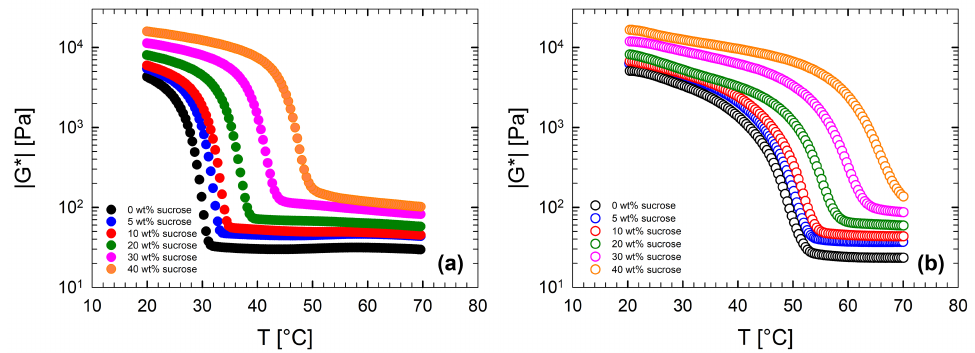
Figure 10. Complex modulus as a function of temperature, at 1 ◦ C/min, for quaternary solutions, with a fixed amount of biopolymers (1.5 wt% κ -c and 1.3 wt% XG) and different sugar levels (see legend for details). ( a ) Cooling, and ( b ) heating ramps.